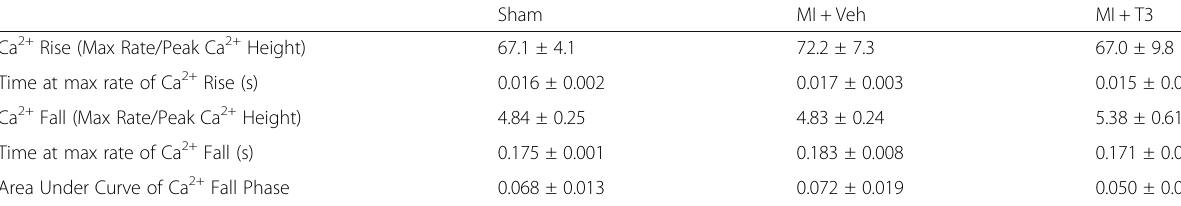
Values are mean±SD. MI, myocardial infarction; Veh, vehicle; T3, triiodothyronine. Sham, n =5; MI+Veh, n=7, MI+T3, n=5; Max Rate is max velocity of Ca 2+ rise (release) or Ca 2+ fall (re-uptake) phase of the